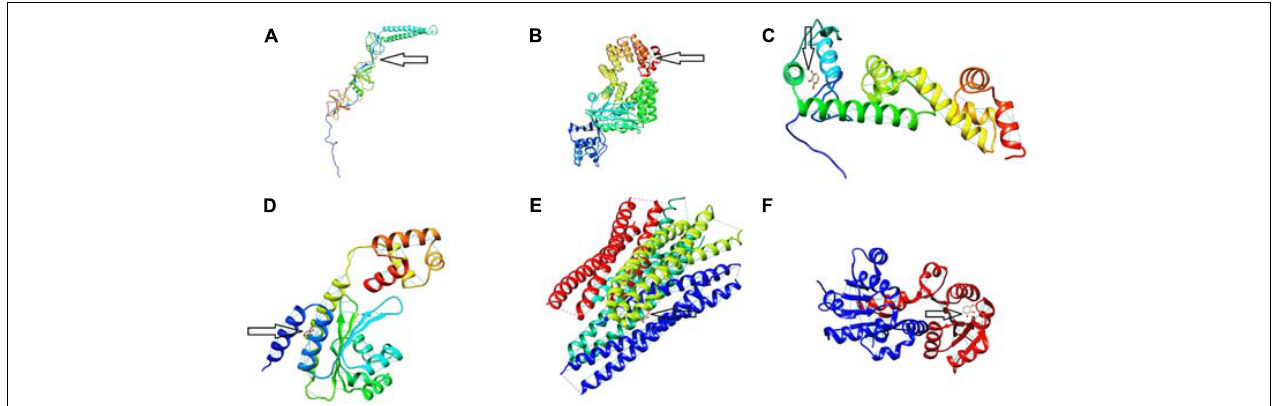
FIGURE 7 | Protein binding site of pyrogallol on (A) acrA, (B) hilA (C) invF, (D) sdiA, (E) sipB, and (F) rck proteins of Salmonella Typhimurium. The arrow indicates the binding site of pyrogallol with the respective proteins and the hydrogen-bond formed between the protein and